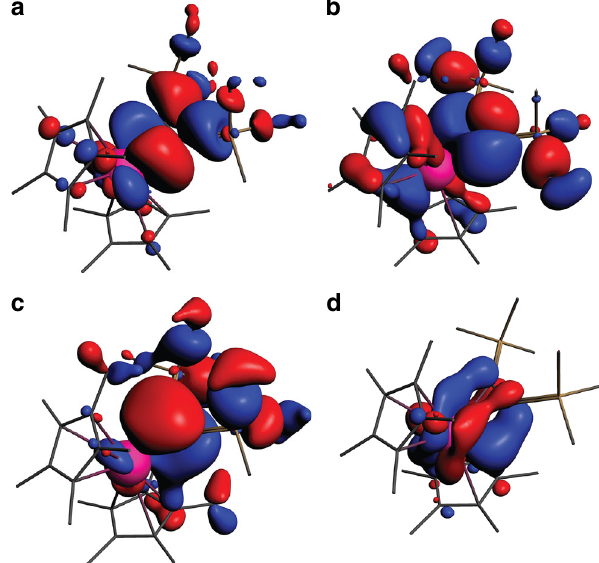
Fig. 4 Selected CMOs of the U metallacyclopropene with trimethylsilyl groups. a HOMO-2, σ ( b ) HOMO-7, σ ( c ) HOMO-8, π ( d ) HOMO-1 (SOMO), δ . H atoms are omitted for clarity. ISO =